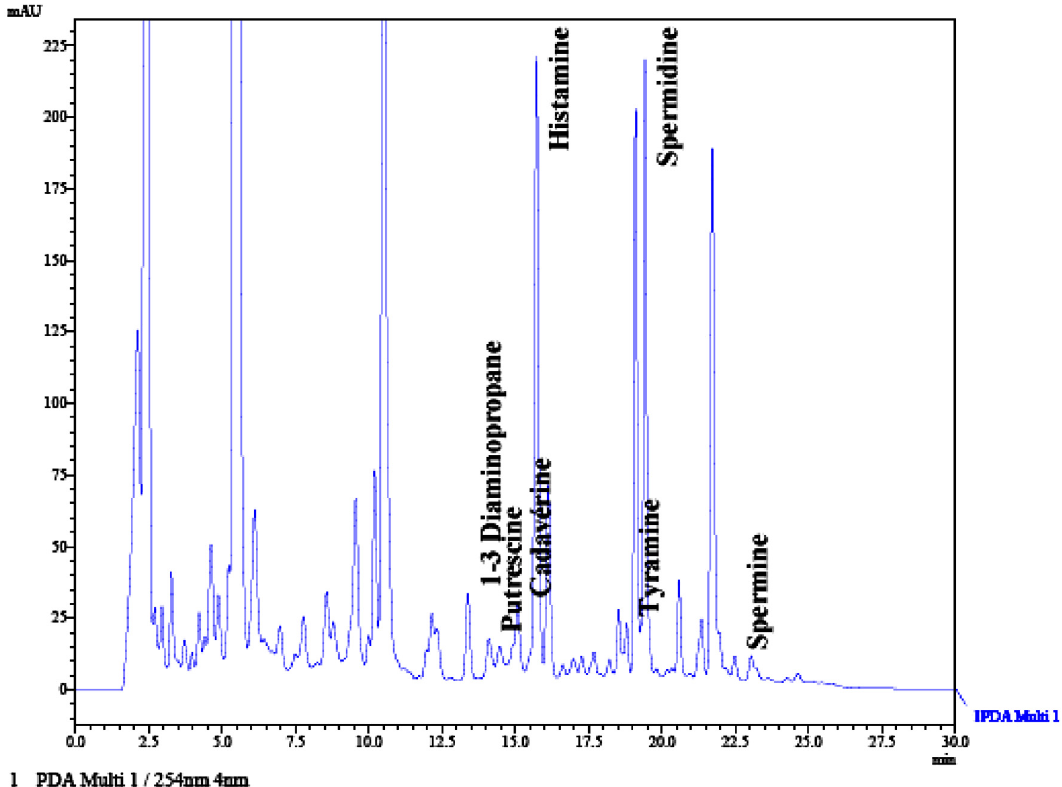
Fig. 6. (Color online) HPLC chromatogram of histamine amount, in the level 1 PTS